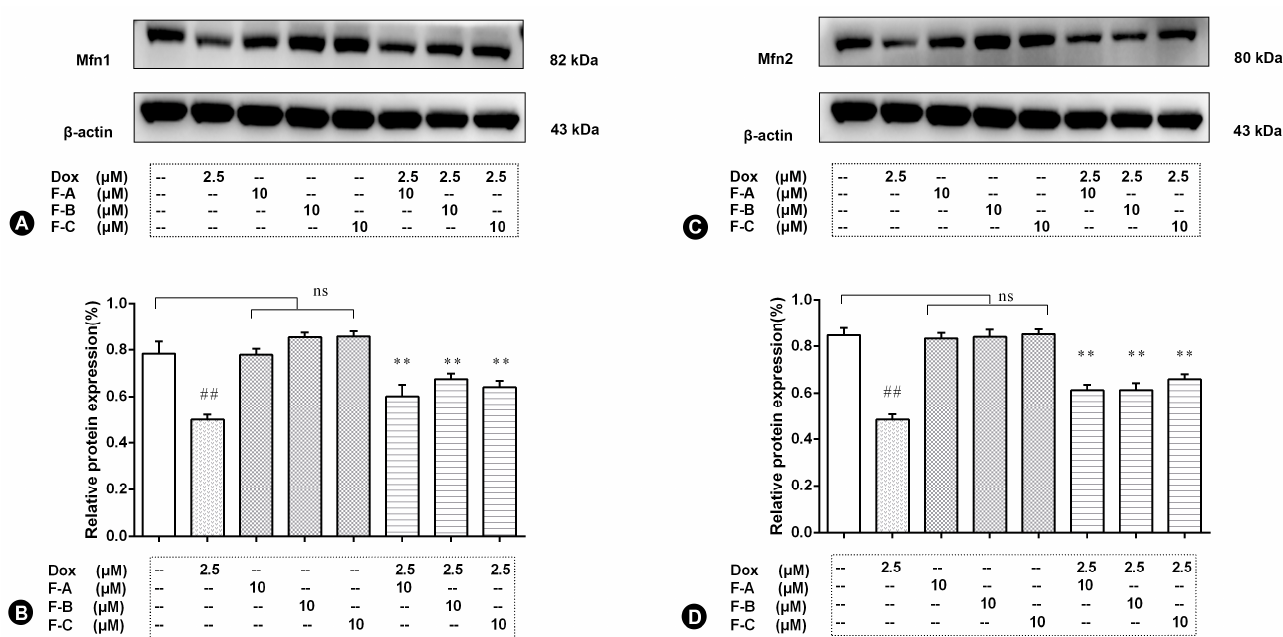
Figure 6. The effects of three flavonoids on mitochondrial fusion proteins Mfn-1 ( A , B ) and Mfn-2 ( C , D ) during Dox-induced cardiotoxicity. Cells were pretreated with same concentrations of F-A, F-B, and F-C (10 μ M) for 1 h, then exposed to Dox for 24 h. Relative folds of Mfn1 ( C ) and Mfn2 ( D ). ( B , D ) The relative expression level of Mfn1and Mfn2 in Dox group significantly decreased compared to the NC group ( p < 0.01). There was no significant change of Mfn1and Mfn2 in the F-A, F-B, and F-C group without Dox. But F-A, F-B, and F-C can significantly enhance the Dox-induced reduction of Mfn1 and Mfn2 in comparison to the Dox model group ( p < 0.01). Results are mean ± SEM from three independent experiments. ## p < 0.01 vs. control, ** p < 0.01 vs. Dox group. ns, not significant.